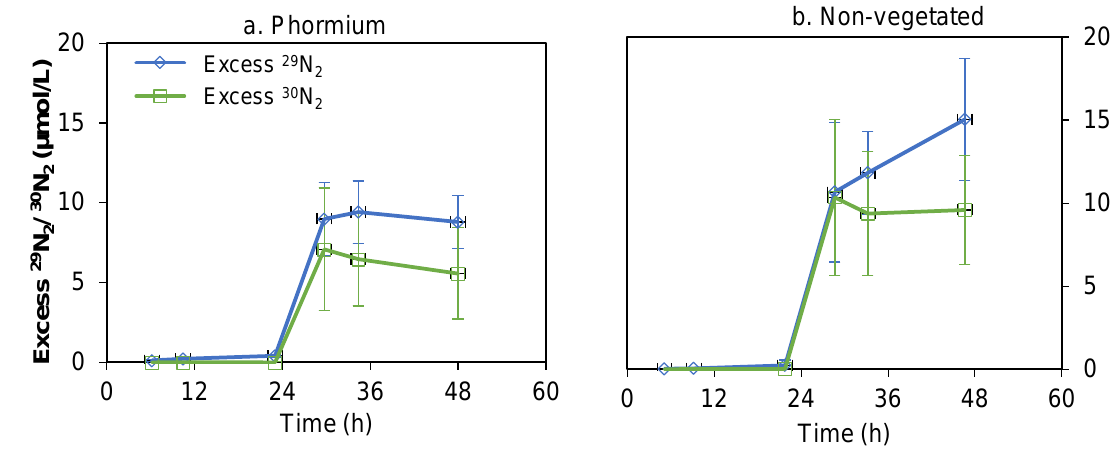
Figure 4. Evolution of excess 29 N 2 and 30 N 2 following dosing with 15 N-urea at t = 0 h and t = 24 h in laboratory columns planted with ( a ) Phormium and ( b ) non-vegetated columns.